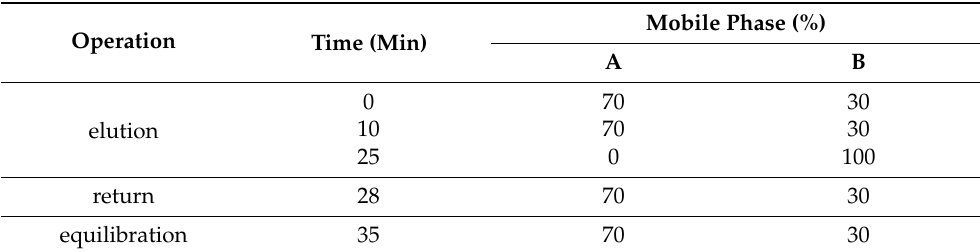
Table 2. The gradient program of mobile phase A and mobile phase B for the separation of biogenic amines in the extract from H. erinaceus